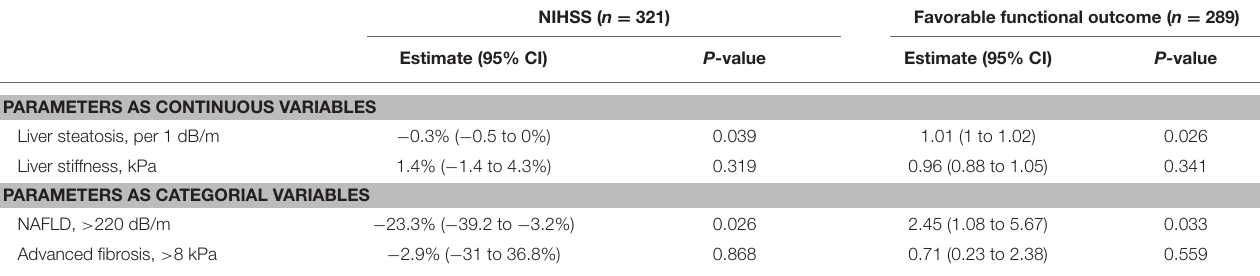
TABLE 3 | Multivariate regression analysis of the degree of liver fibrosis and steatosis.